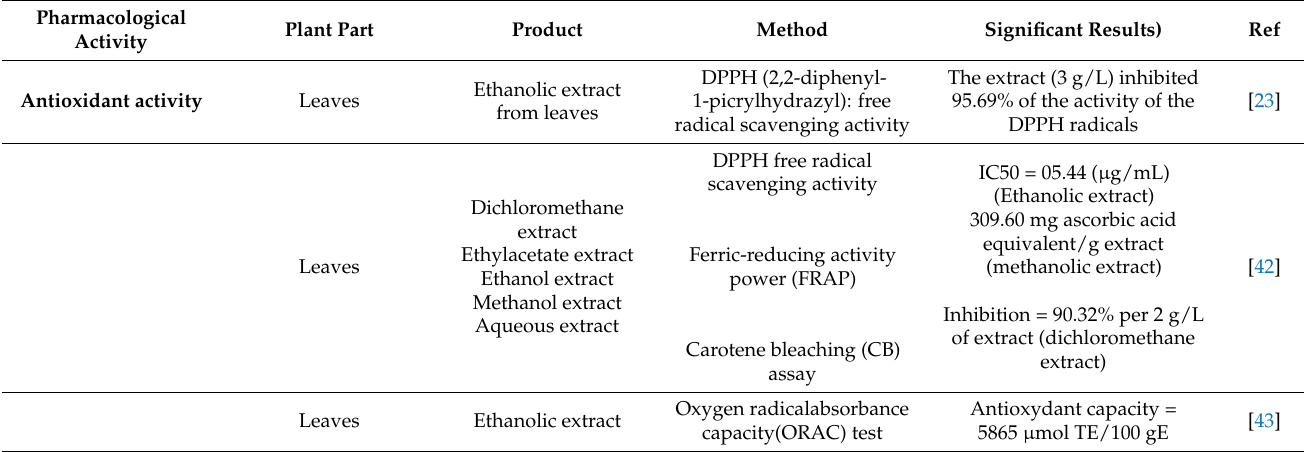
Table 3. Pharmacological activities of lentisk phenolic